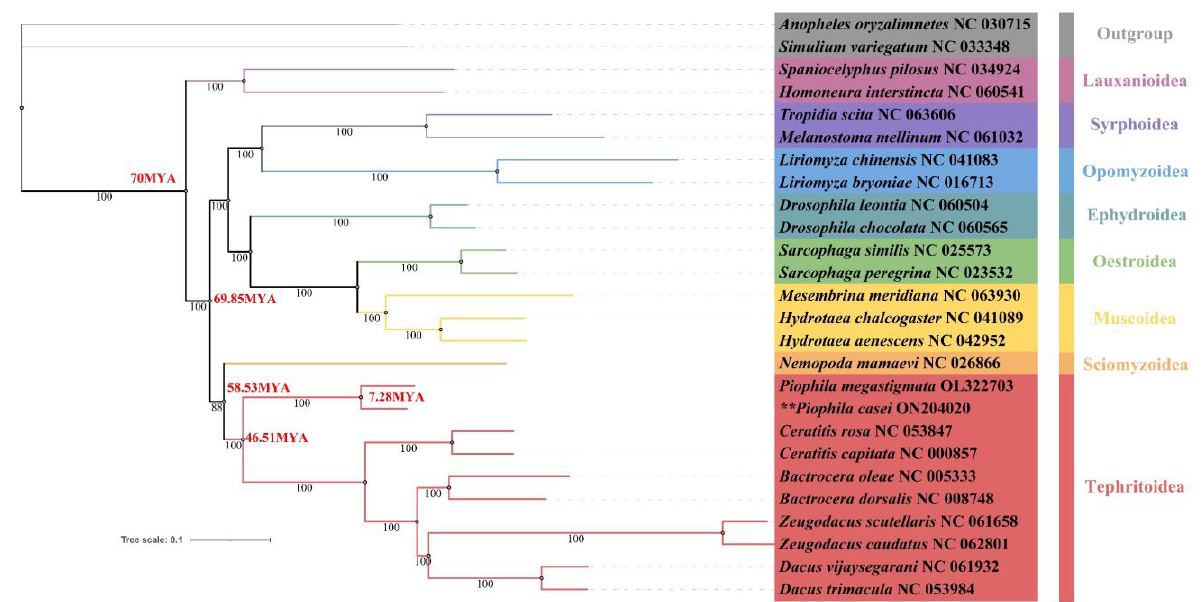
Figure 9. A genome-wide phylogenetic tree of the mitochondria of 26 dipteran insect species con- structed based on BI analysis. The red values in the developmental tree indicate the time of divergence between species MYA (million years ago). (The specie marked with ** is the main subjects of study in this research).